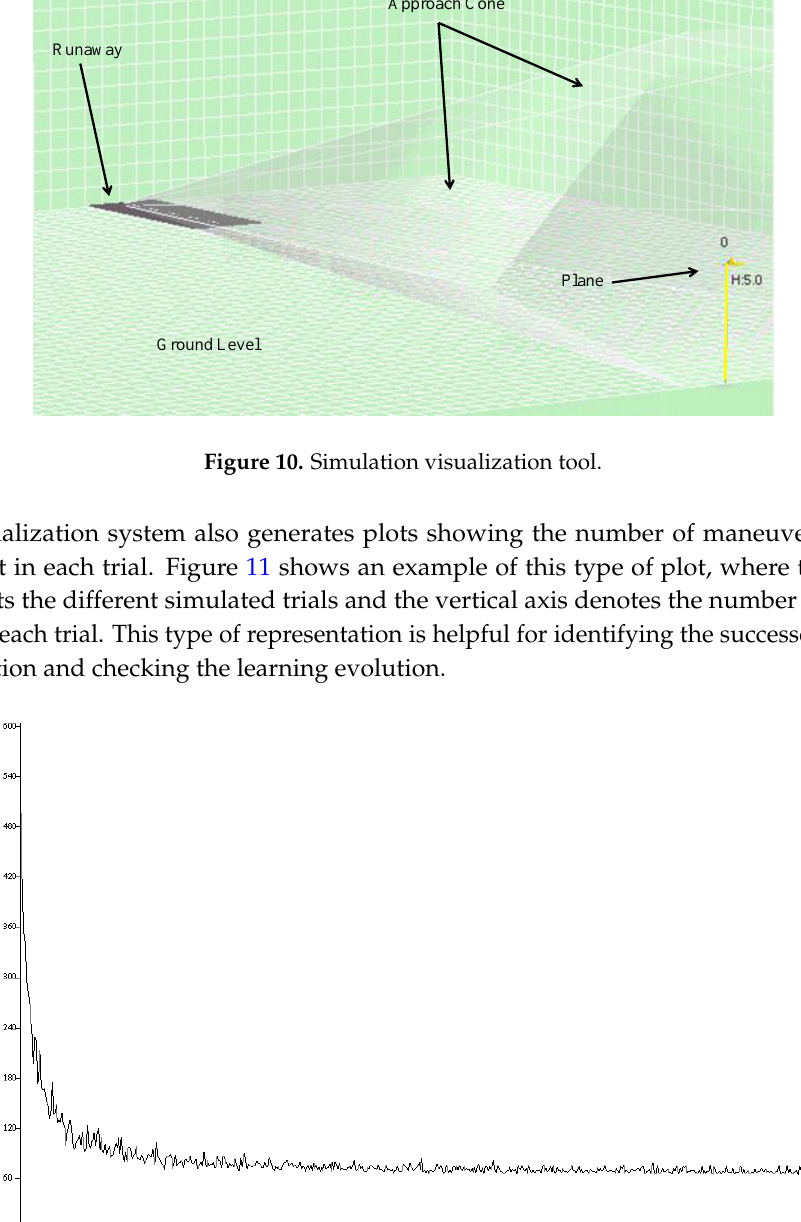
Figure 11. Example of plot associated with a simulation.